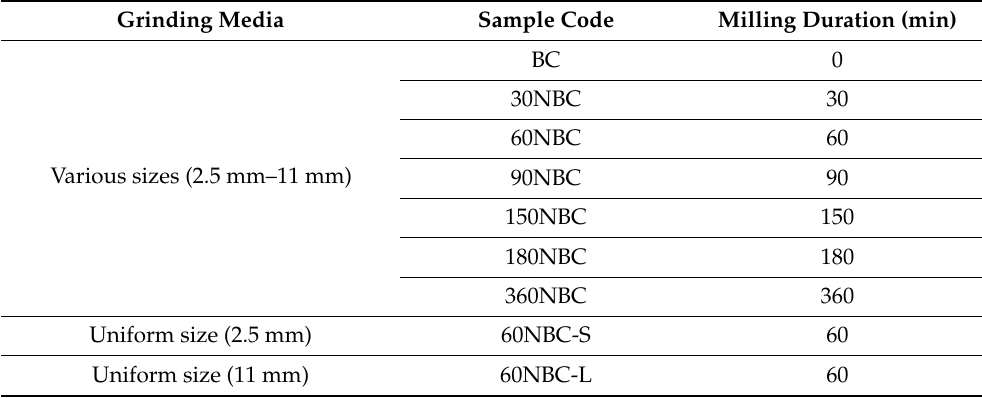
Table 1. The sample codes and their designated sizes of the grinding media and ball milling